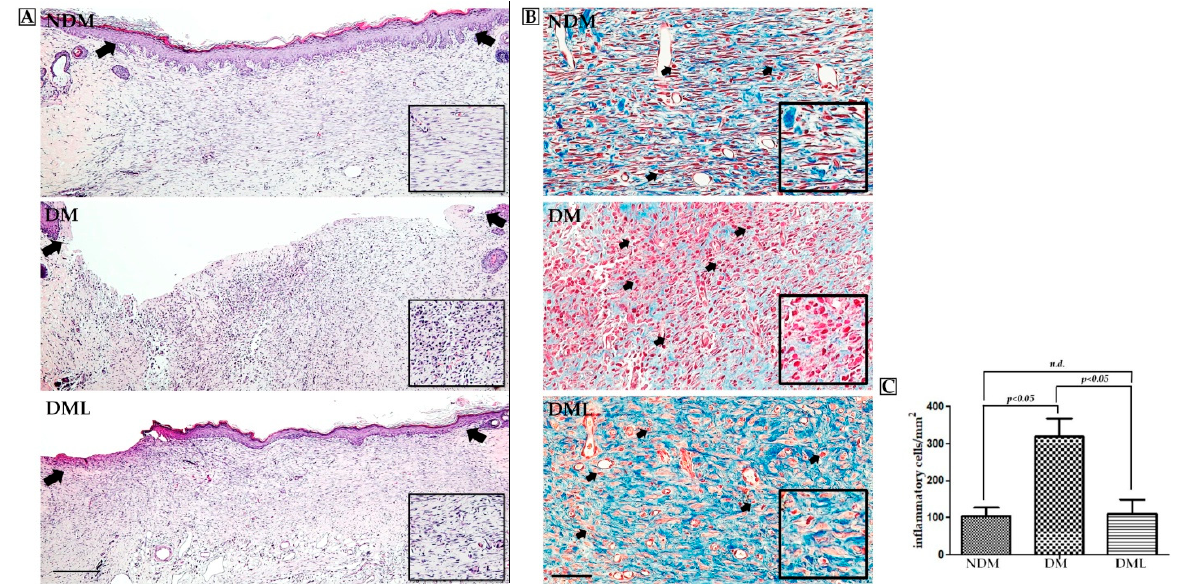
Figure 3. Luteolin accelerates wound re-epithelialization and ameliorated inflammatory cell infiltration. ( A ) Histological sections from the wound site demonstrated complete and incomplete re-epithelialization and collagen deposition on day 14. Delayed re-epithelialization was observed in the DM group (black arrowheads denote re-epithelization of the wound). Scale bars: 300 μ m. ( B ) Representative images of skin wounds (Masson trichrome staining) showed loss of infiltrating inflammatory cells in the NDM and DML groups (arrowheads). ( C ) Average numbers of inflammatory cells were determined using Image J software. Values of individual groups are presented as mean ± SEM. Difference was considered significant when p < 0.05. Scale bars: 200 μ m.